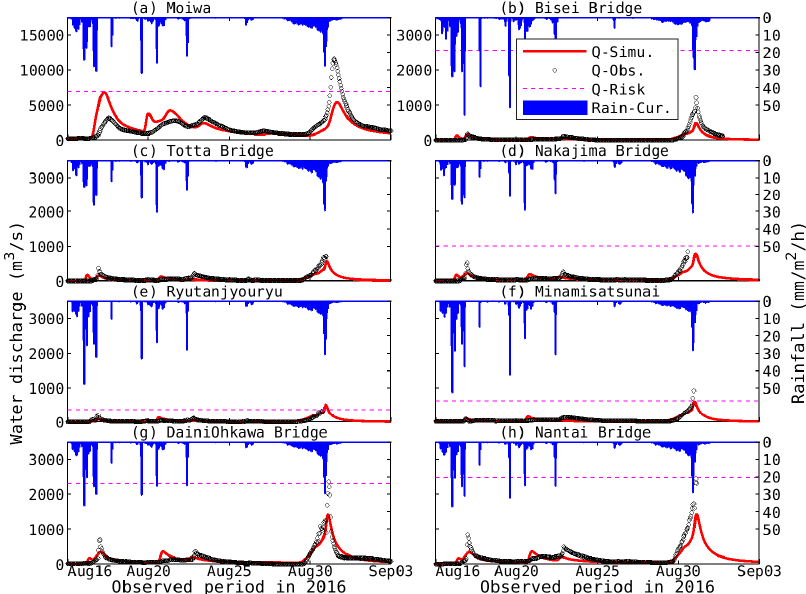
Figure 5. Discharge comparison of the raw data of the CNTL simulation between the current flood simulation (red line) and observation (black circle) at the gauge stations in the main stream and tributaries with mean rainfall (blue box) over an upstream area from each gauge station: ( a ) Moiwa, ( b ) Bisei Bridge, ( c ) Totta Bridge, ( d ) Nakajima Bridge, ( e ) Ryutanjyouryu, ( f ) Minamisatsunai, ( g ) Dainiohkawa Bridge, and ( h ) Nantai Bridge. The pink lines denote the flood risk discharges. Note that the flood risk discharge at the Totta Bridge Station was higher than the maximum value on the y axis.